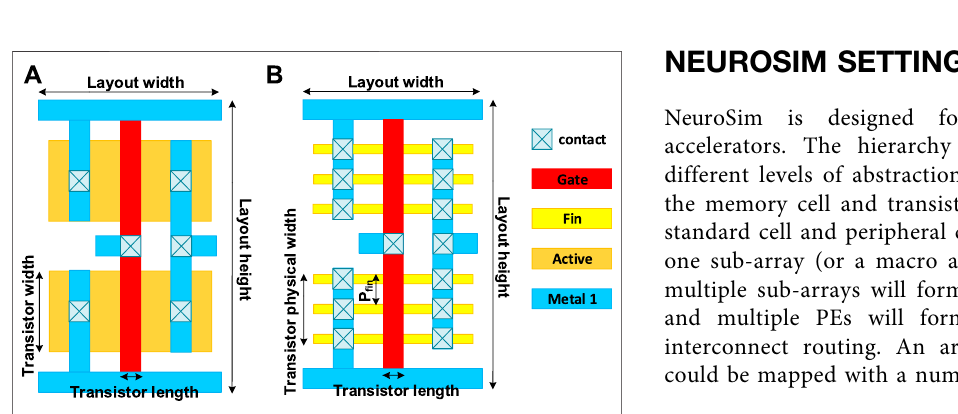
FIGURE 3 | Layout of inverter cells for (A) bulk and (B) FinFET.